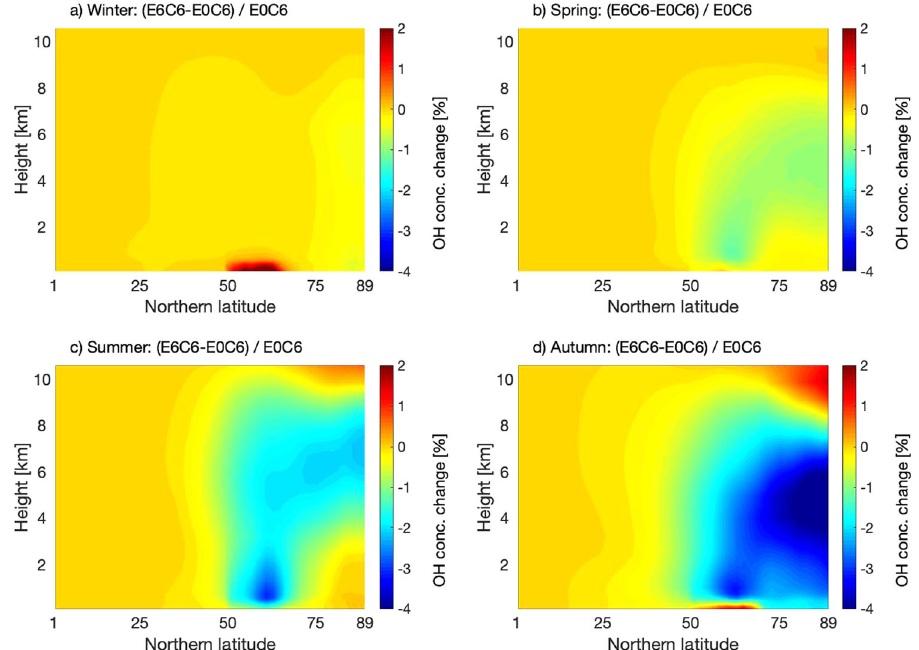
Fig. 3 Hydroxyl radical seasonal change in the Northern hemisphere. a – d The zonally averaged daily concentration changes of the hydroxyl radical between scenarios E6C6 and E0C6 relative to the mean value of E0C6 at each latitude for the four seasons calculated with TM5 model (winter = December – February; spring = March – May; summer = June – August; autumn = September –